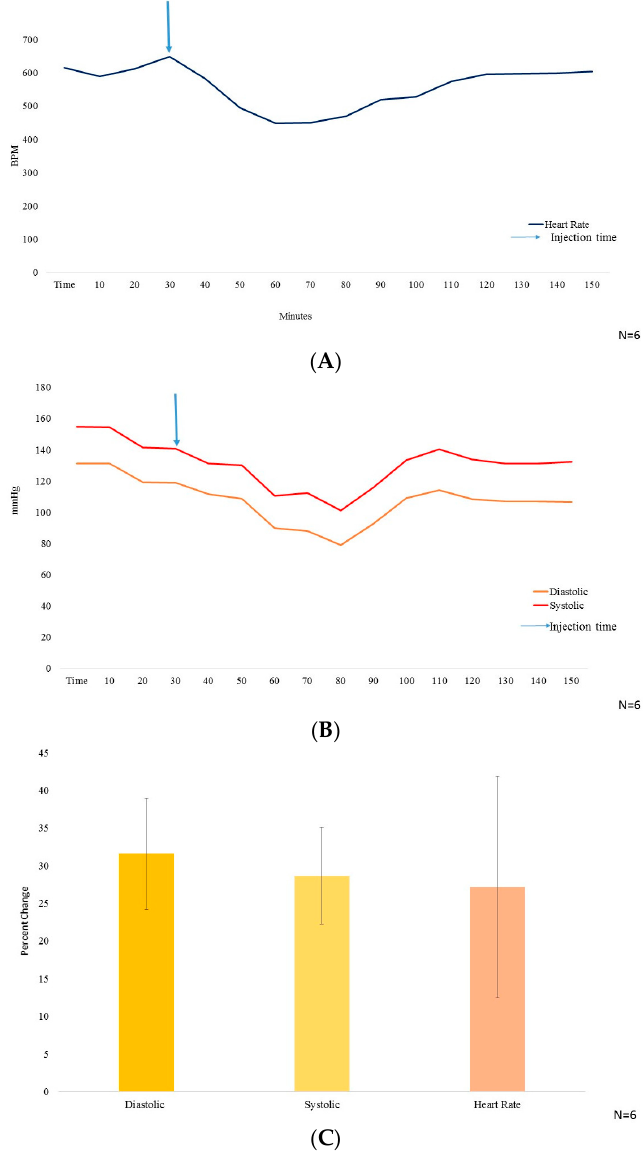
Figure 2. ( A ) The heart rate measurement in beats per minute (BPM) on y axis, with time (minutes) from t = 0–60 on x axis (N = 6); ( B ) The blood pressure (mmHg) on y axis, wherein, systolic BP is represented by red color line and diastolic BP represented by yellow color, with time from t = 0–160 (minutes) on x axis. 10 mg/kg BW of GA was injected i.p. at t = 30 min (N = 6); ( C ) Graphical representation of the % decrease in systolic and diastolic Blood pressure along with heart rate (N = 6).